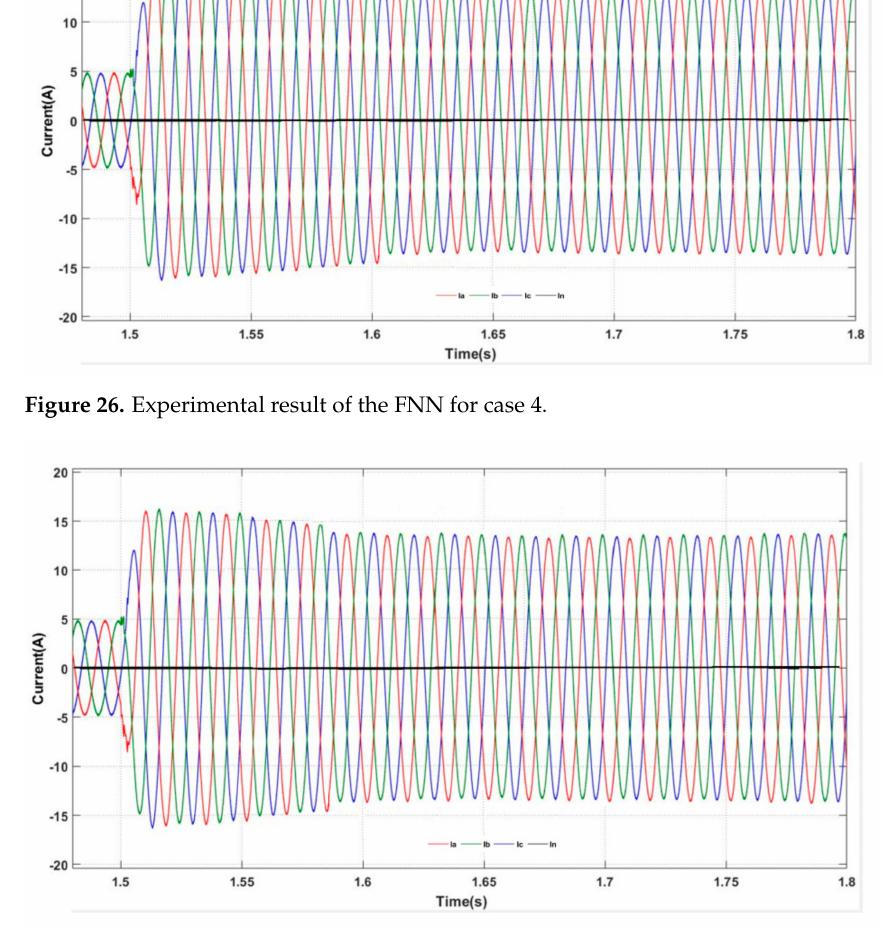
Figure 27. Experimental result of the proposed control mechanism for case